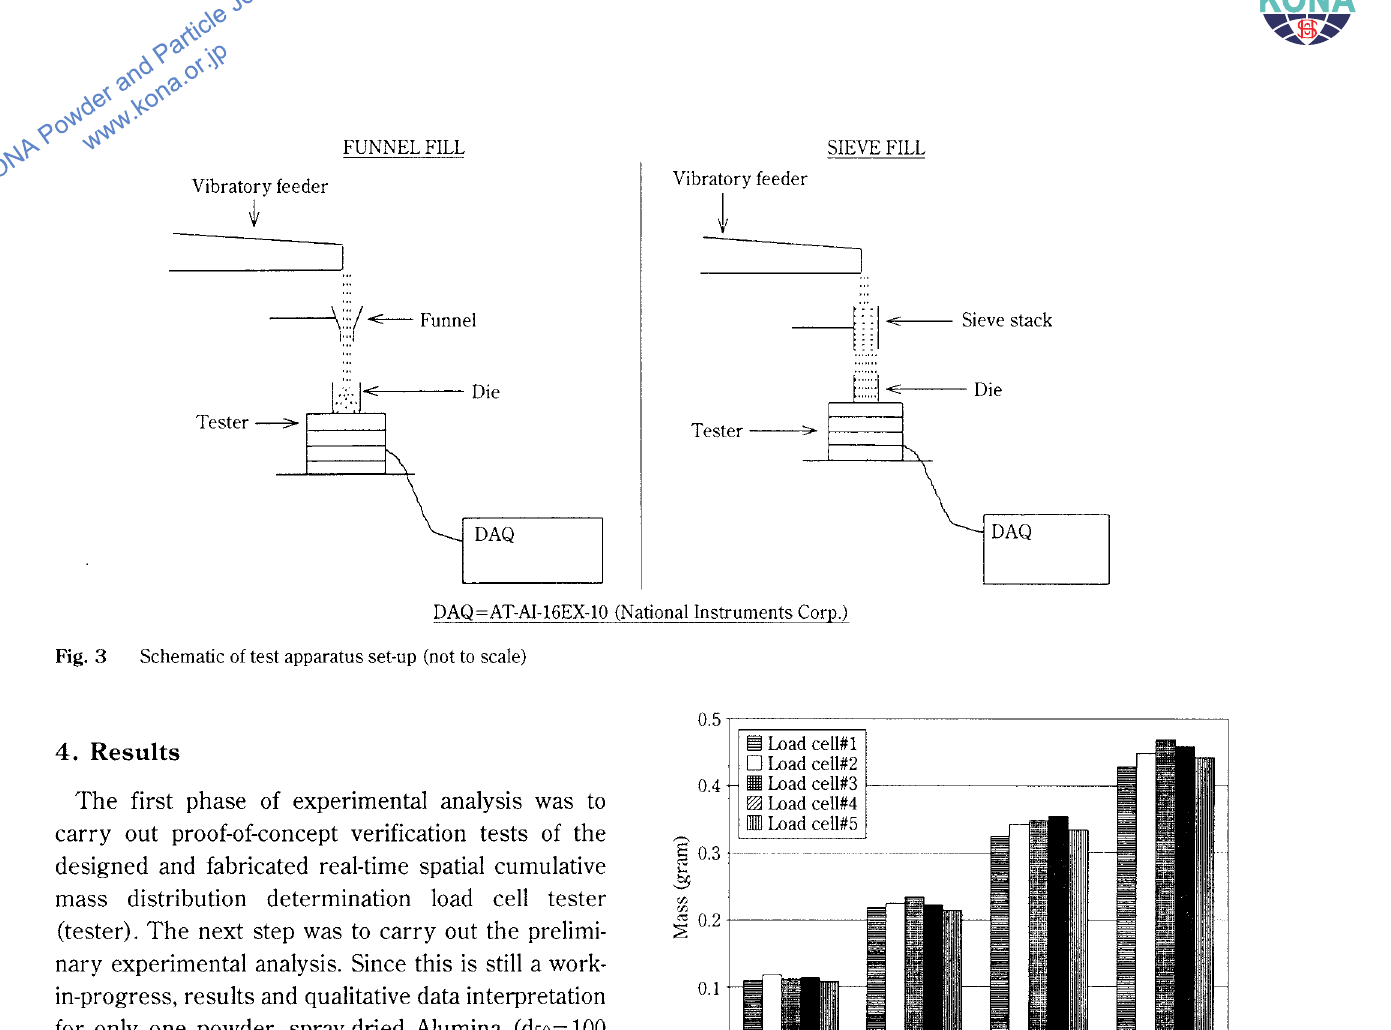
Load measurements across load cells at different die fill depths with water oretical values for the load at different depths of fill ranged from 2.14 to 2.19. As expected, measured